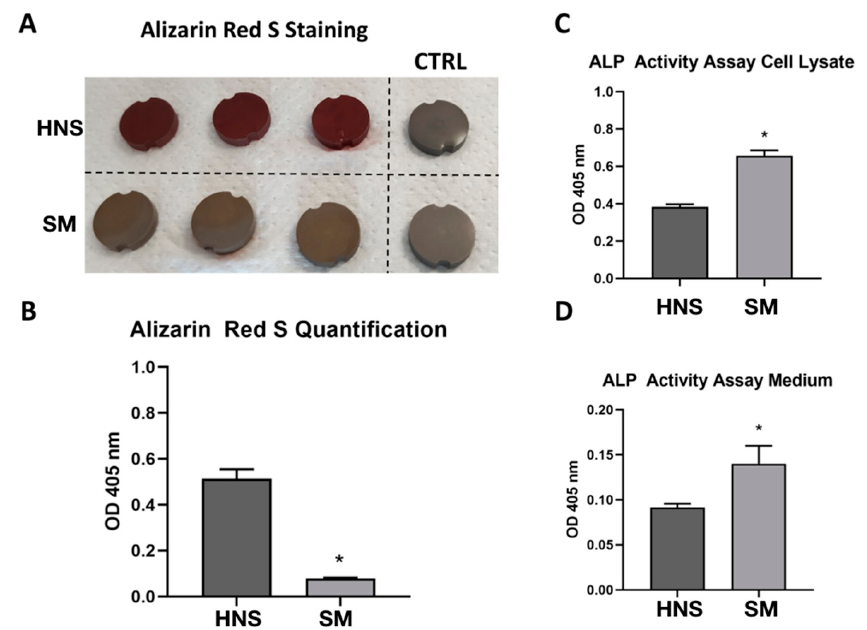
Figure 5. Osteogenic activity of MC3T3-E1 cultured for 21 days in osteogenic medium on HNS or SM surfaces. Representative picture of staining of calcium deposit on titanium samples through Alizarin Red S ( A ). Quantification of optical density at 405 nm of solubilized Alizarin Red S staining with 10% acetic acid ( B ). Evaluation of ALP activity on cell lysate ( C ) and culture medium ( D ) of MC3T3-E1 by using ALP Activity Assay Kit ab83369 (Abcam). Values represent mean ± SEM. The symbol (*) indicates the statistical significance vs. HNS surface, considering a p -value < 0.05.